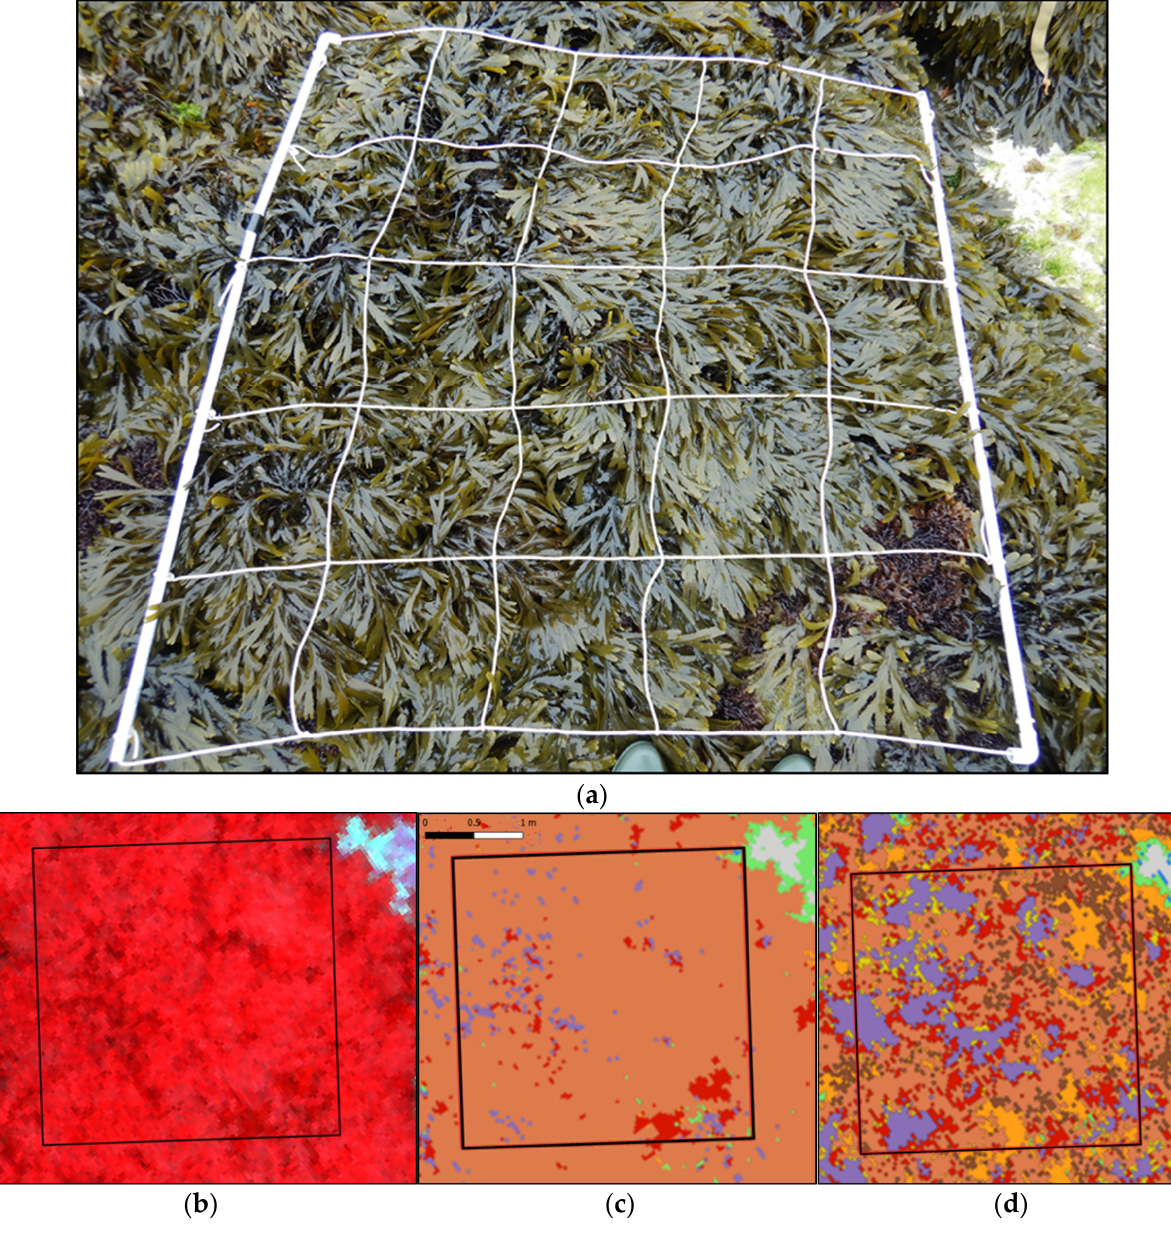
Figure A2. ( a ) Picture of a sampling spot on the Fser level at Porspoder taken during field sampling in June 2021. ( b ) NIR-G-B image of the same sampling spot. ( c ) Result of the MLC classification. ( d ) Result of the SAM classification. The black square corresponds to the mobile grid structure used for field sampling. Color code in ( c , d ) corresponds to the following classes: ‘ P. canaliculata ’ (brown), ‘ F. spiralis ’ (yellow), ‘ A. nodosum ’ (purple), ‘ F. serratus ’ (Coral), ‘ H. elongata ’ (orange), ‘Red’ algae (red), ‘Green’ algae (green), ‘Substratum’ (grey) and ‘Water’ (blue).